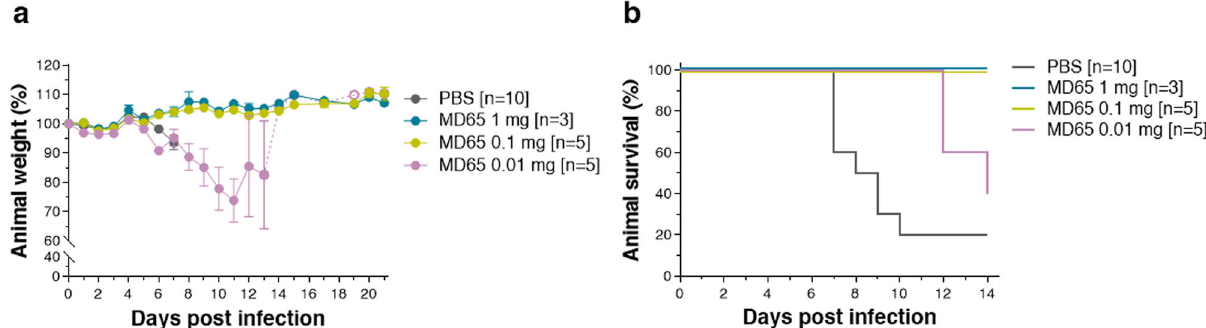
Fig. 6 Dose-dependent therapeutic ef fi cacy of MD65. Single doses of 1, 0.1, and 0.01 mg MD65 Ab/animal were administered at day 2 post viral infection. a Body weight pro fi les. b Kaplan – Meyer surviving curves. Curves describe mice treated with the indicated doses of MD65 (see color legend within panels) and control animals, administered with PBS (gray line). Data represent means± SEM. Body weight change is displayed as the percentage of initial weight. Only data of the fi rst 7 days are presented in the control group exhibiting signi fi cant mortality. In case of the mice treated with 0.01 mg MD65, the weight of the surviving animal is indicated by hollow circles and dashed